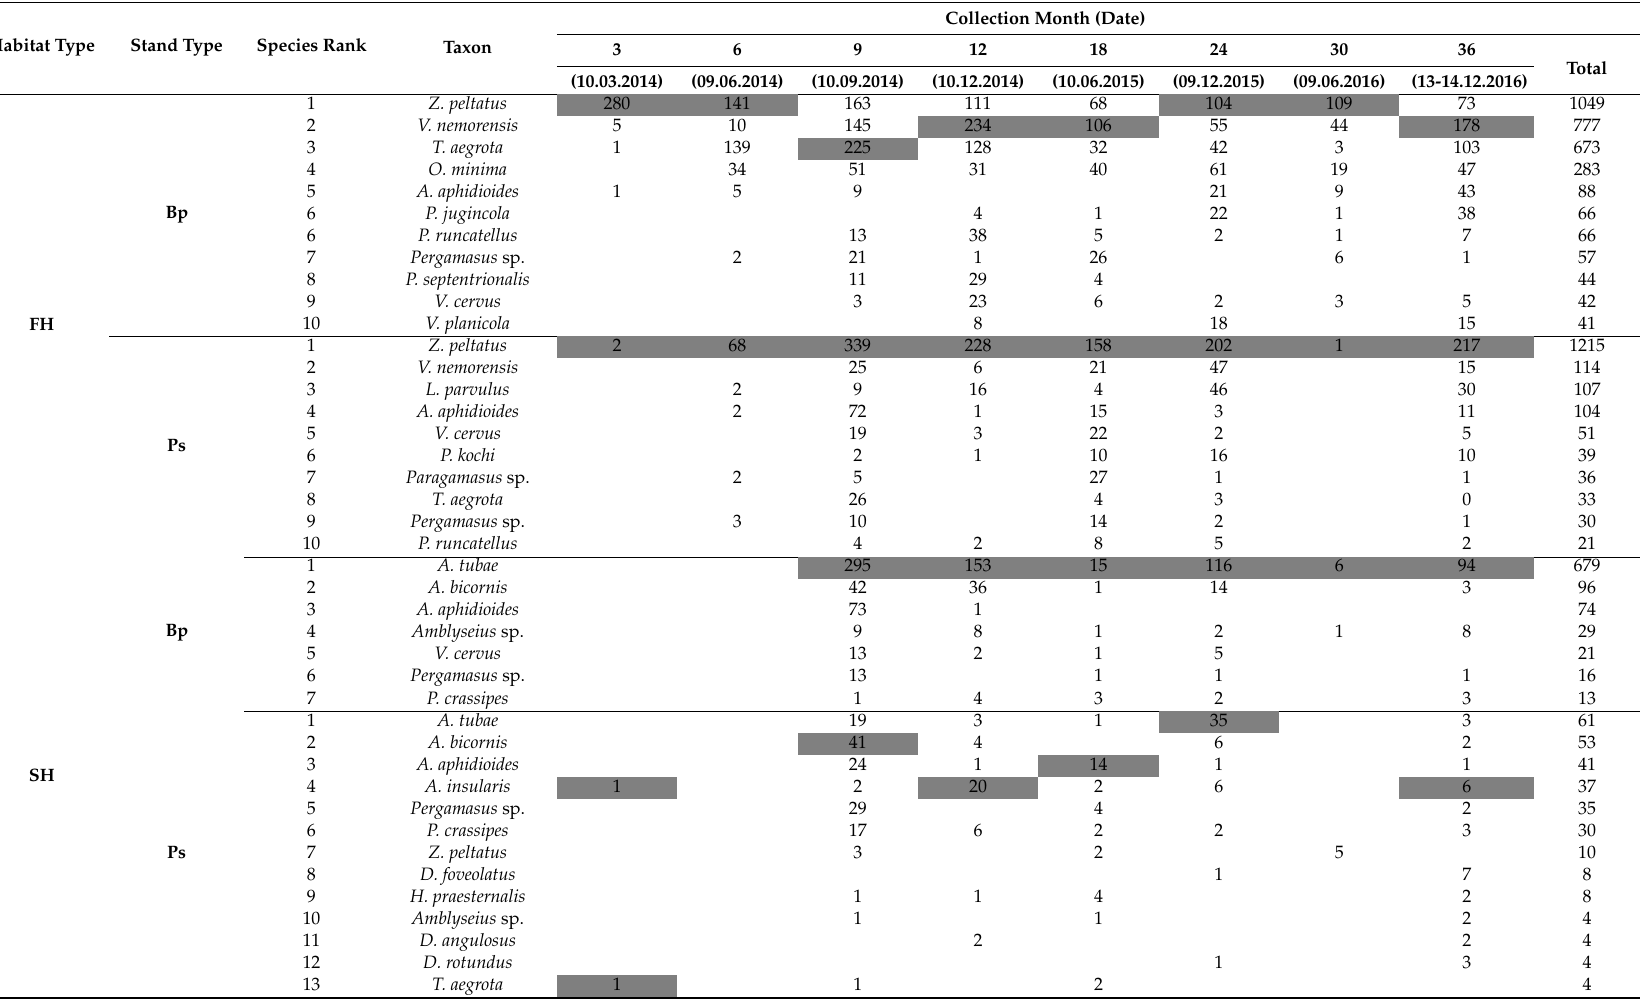
Table A5. Succession and appearance of the most abundant mites species (Dominance >1%) in Betula pendula (Bp) and Pinus sylvestris (Ps) stands growing in forest habitat (FH) and spoil heap (SH). Shaded cells show the most abundant species within the collection months in each stand type. Habitat